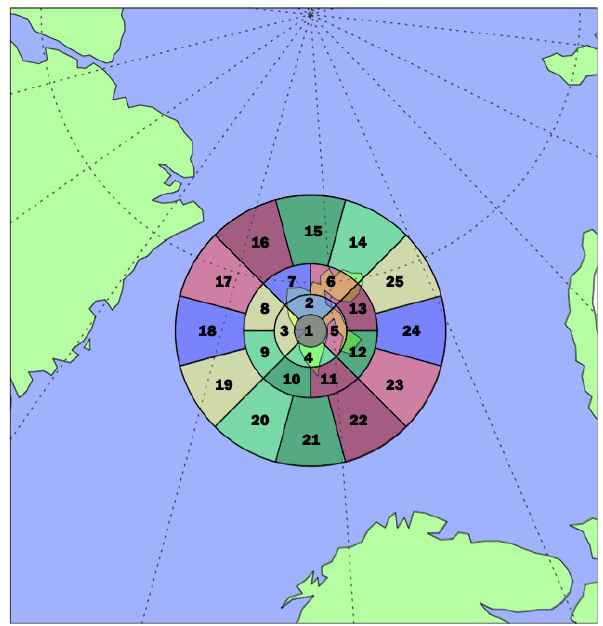
Fig. 1. SCANDI zone map showing the field-of-view of each zone. The full field-of-view has a radius of 590km for 630nm emission peak altitude of 250km.